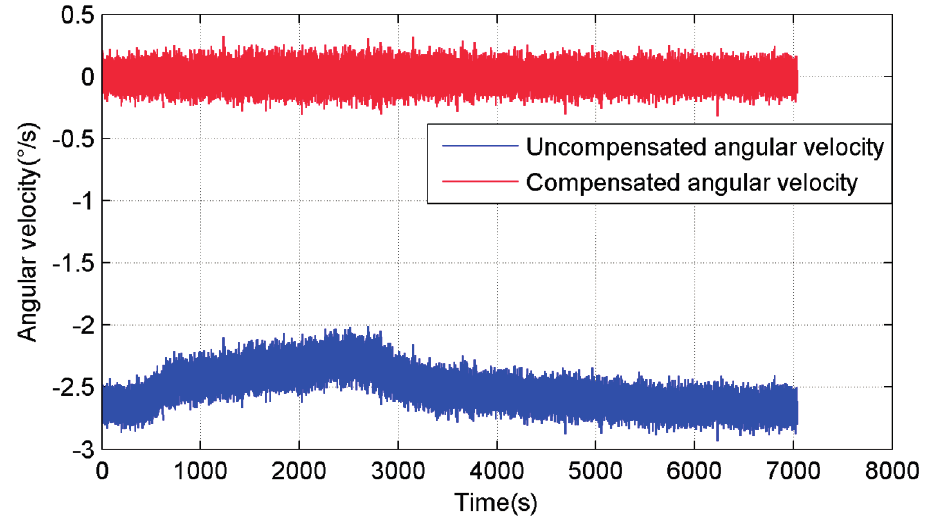
Figure 3. Uncompensated and compensated angular velocity of the gyroscope.